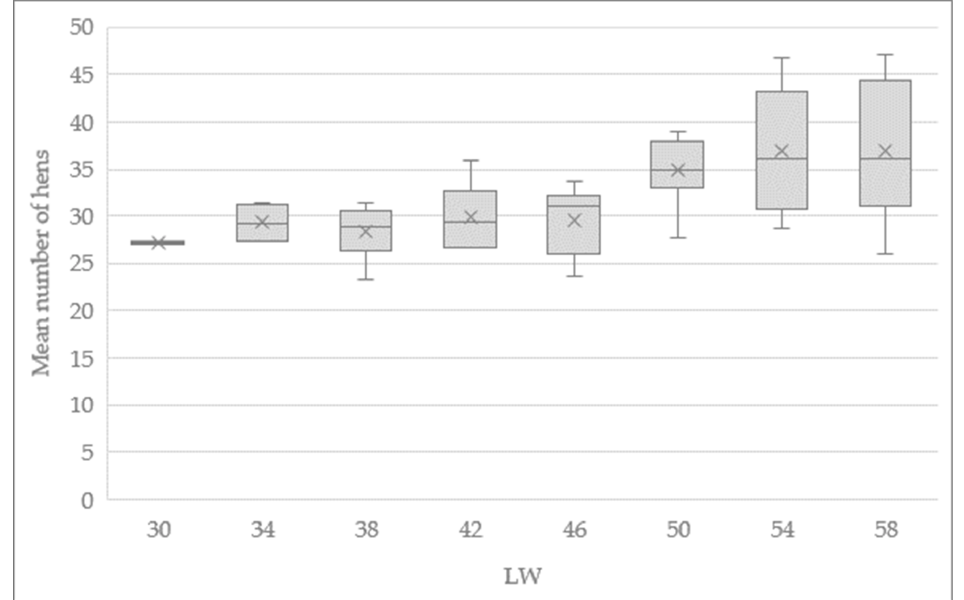
Figure 4. Mean number of hens in the observation areas beneath the device (ScA 1 and ScA 3) during the examined times of maize supply for birds of different ages (LW: F = 3.75; p < 0.01). Boxplots indicate the data range, median, lower, and upper quartiles, and mean value.